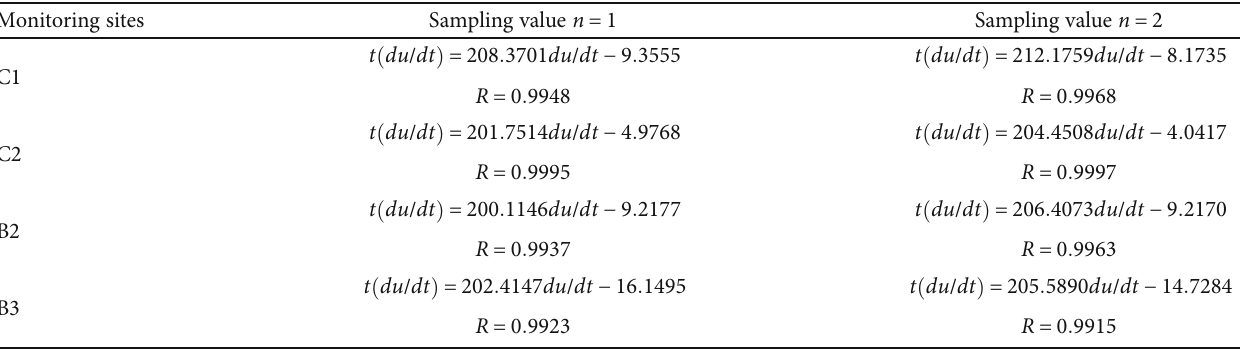
Table 3: Predicted